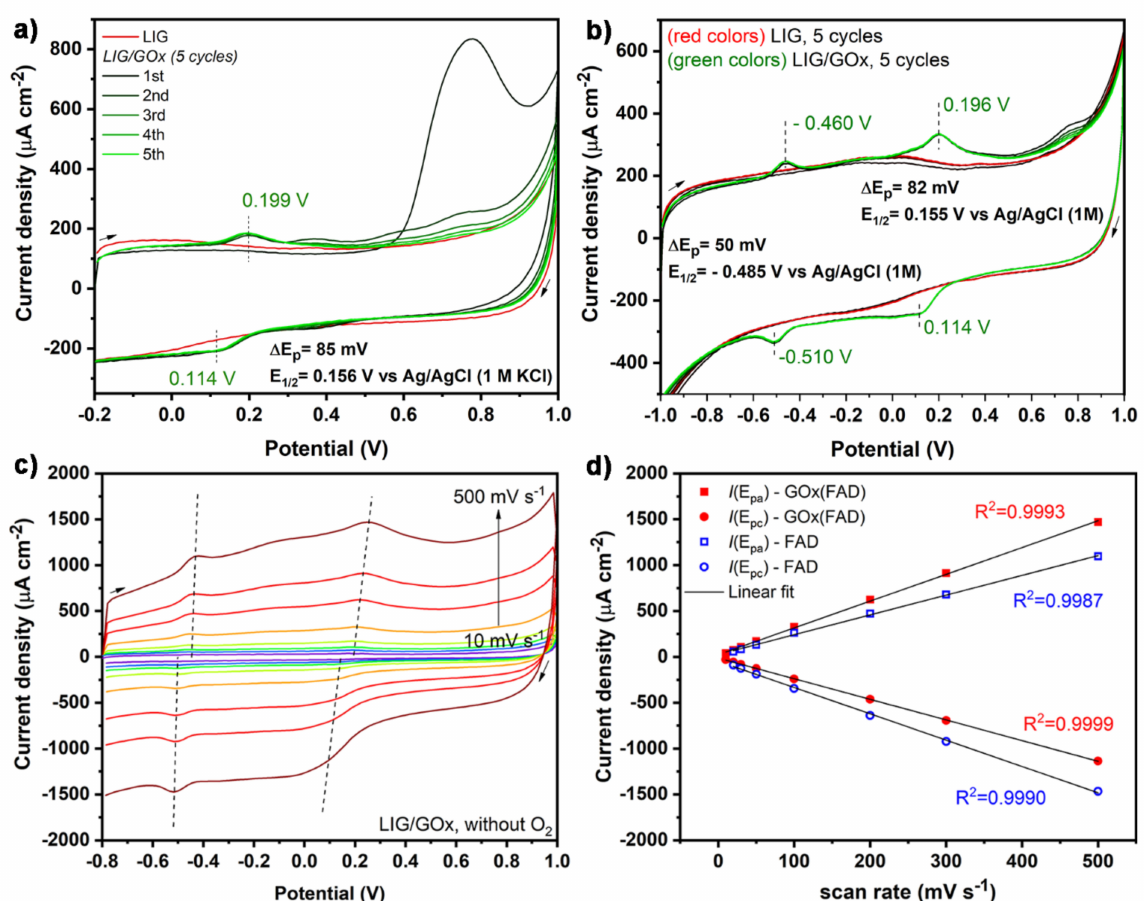
Figure 5. Cyclic voltammograms of: ( a ) LIG (the fifth cycle is presented) and LIG/GOx (five cycles are displayed) in a potential range from − 0.2 to +1.0 V at 100 mVs − 1 ; ( b ) LIG and LIG/GOx in a potential range from − 1.0 to +1.0 V at 100 mVs − 1 after CV in (a). ( c ) Cyclic voltammograms of the LIG/GOx electrode at different scan rates: 10, 20, 30, 50, 100, 200, 300 and 500 mVs − 1 ; and ( d ) the respective anodic, I (E pa ), and cathodic, I (E pc ), peak currents of FAD and GOx(FAD) adsorbed on LIG, as a function of the scan rate. All the measurements were performed in the absence of O 2